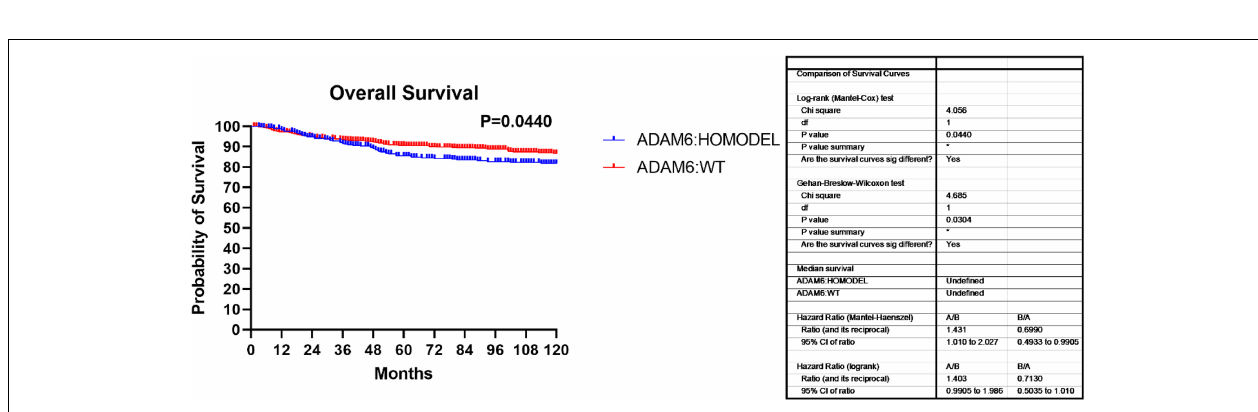
Frontiers in Cell and Developmental Biology |